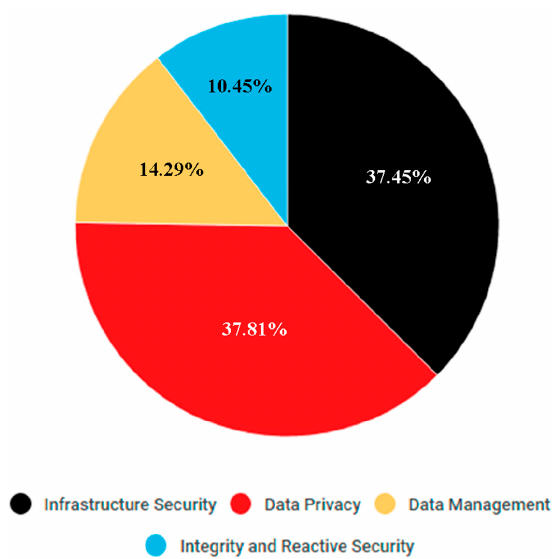
Figure 7. Papers grouped by main categories. Table 2. Combined